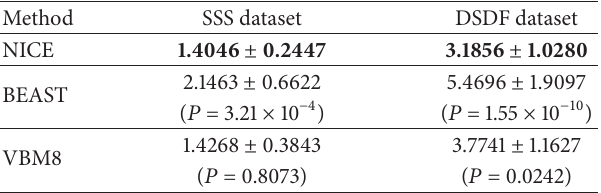
Table 4: Percent mean IC volume differences for the SSS dataset. NICE was compared to the other two methods ( 𝑃 values). Best results are in